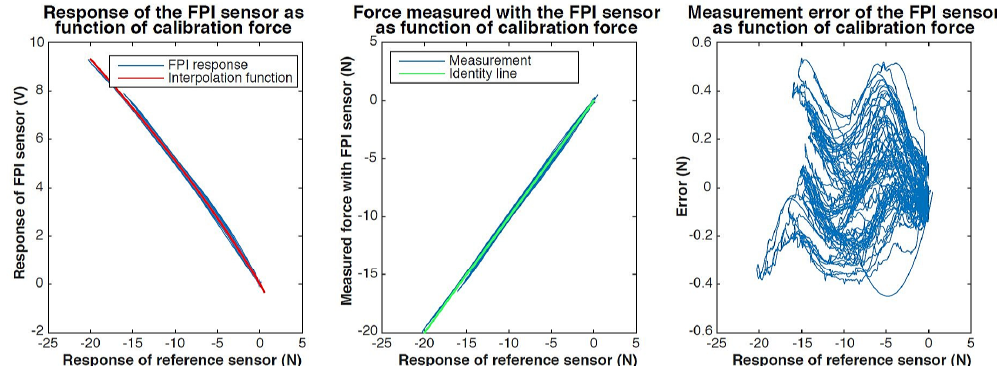
Figure 9. Calibration results of dynamic calibration with temperatures varying between 22 °C and 40° of the prototype of the quartz capillary concept. The response of the FPI as function of the calibration force, together with the fit, is shown on the left. The center figure shows the force measured with the FPI, calculated using the interpolation function, as function of the calibration force and the indentity line ( y = x ) as a reference. The measurement error of the FPI sensor as function of the calibration force is shown on the right.